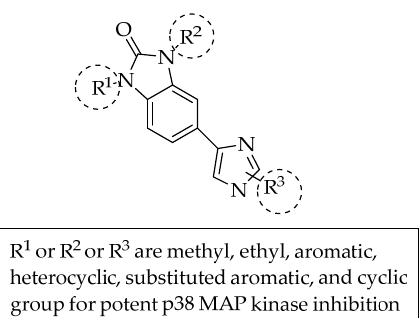
Figure 13. Benzimidazol-2-one compounds bearing five positions with substituted imidazole.